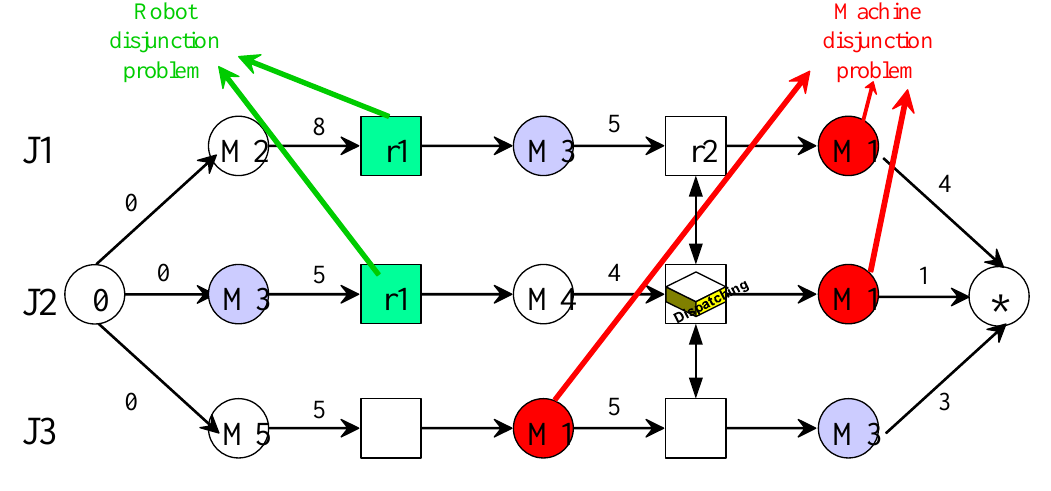
Fig. 1. Exact route dispatching